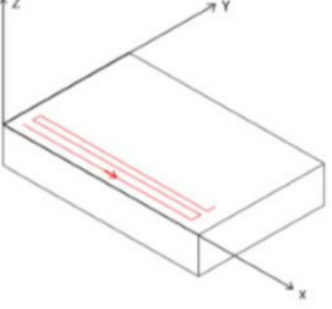
Figure 1. Diagram showing the path of the applied laser